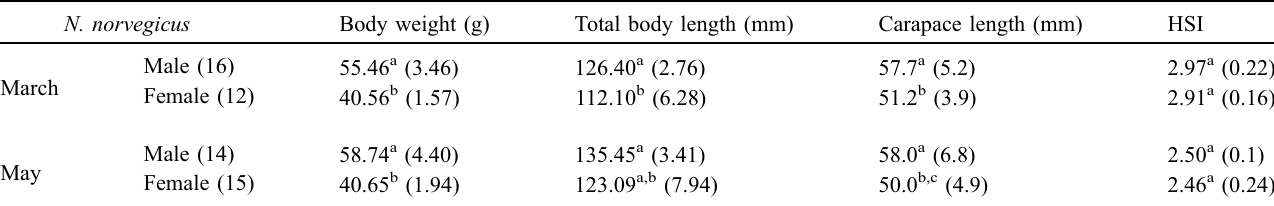
Table 1. Body weight, total body length, carapace length and HIS of the N. norvegicus for comparison between months and sex, with number of samples in parenthesis. Results are given as means with standard error of mean within parenthesis. Means in a column per month and per sex followed by the same superscript are not signi fi cantly different ( p > 0.05).